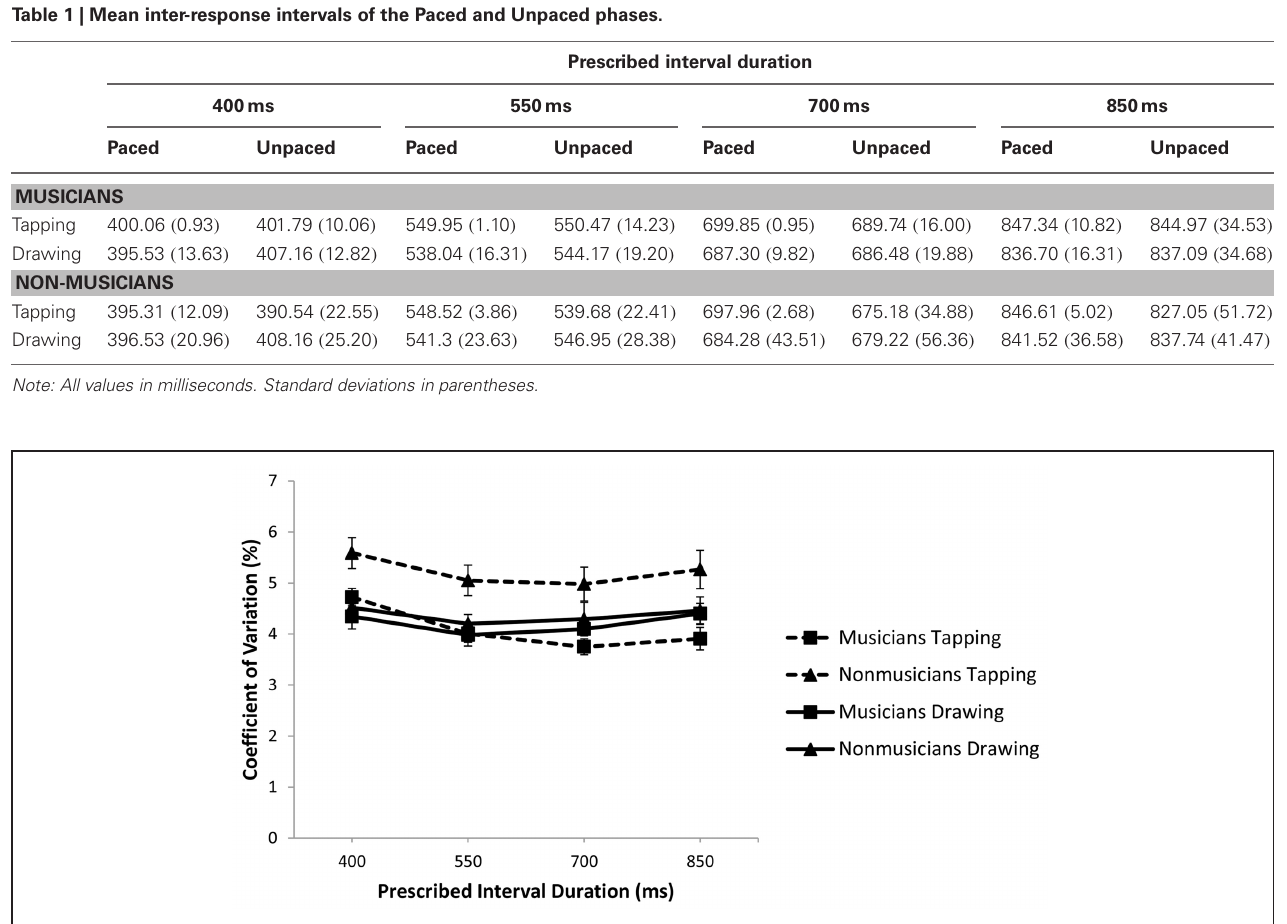
FIGURE 1 | Coefficient of variation of the Unpaced IRI, plotted against prescribed interval duration and with standard error bars.